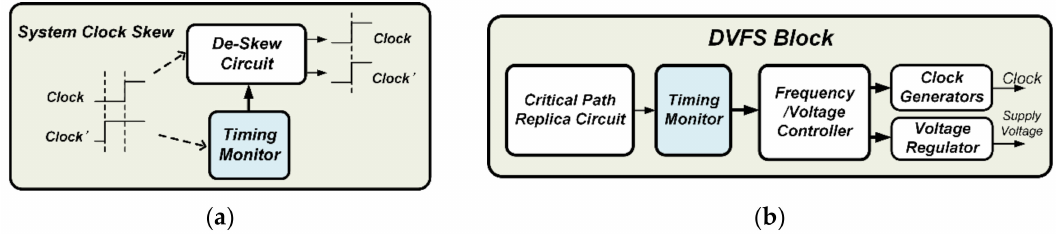
Figure 1. The role of the timing monitor in SoC. ( a ) Uncertain timing monitoring; ( b ) Delay measurement of the critical delay path for